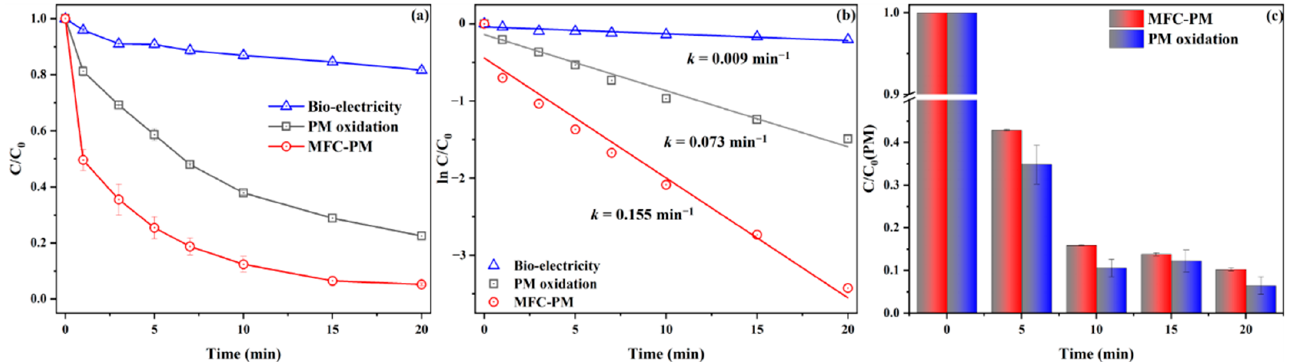
Figure 1. The removal ratio of DCF ( a ), DCF degradation kinetics ( b ), and PM consumption ( c ) by the PM, MFC-E, and MFC-PM processes (pH = 3.0; [DCF] 0 = 60 µM; external resistance = 0 Ω ; [PM] 0 = 30 µM).